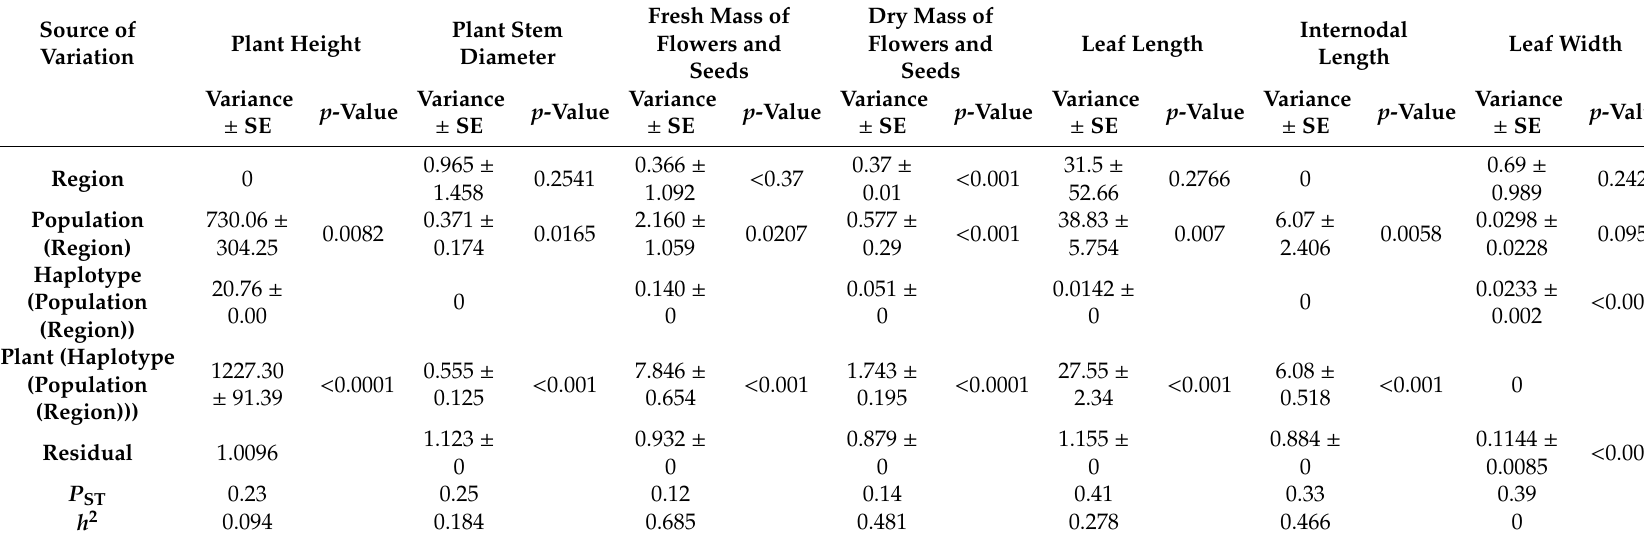
Table 2. Variance in Phragmites australis morphological characters from sixteen natural stands in Qu é bec, Canada and Kashmir, India (SE = Standard Error). Source